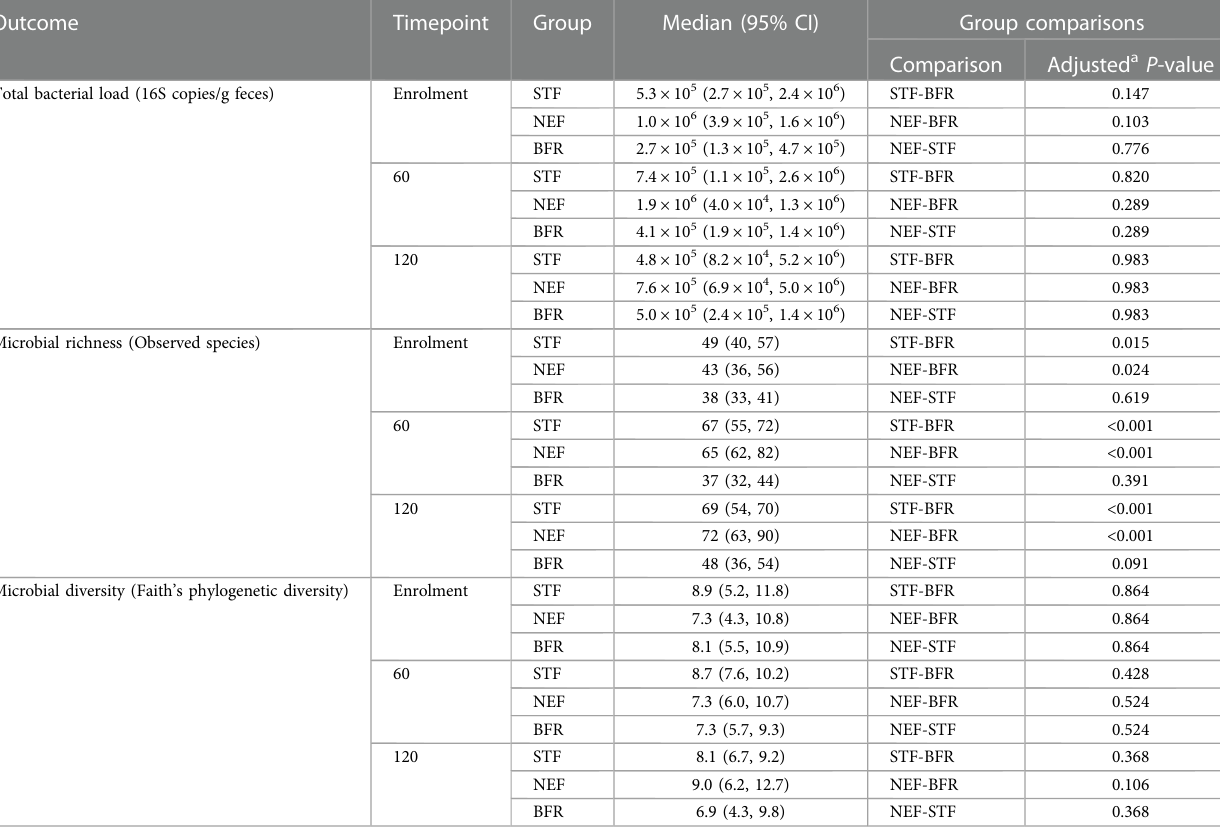
TABLE 9 Fecal microbiome analysis of all groups at enrolment, 60 days and 120 days of age.